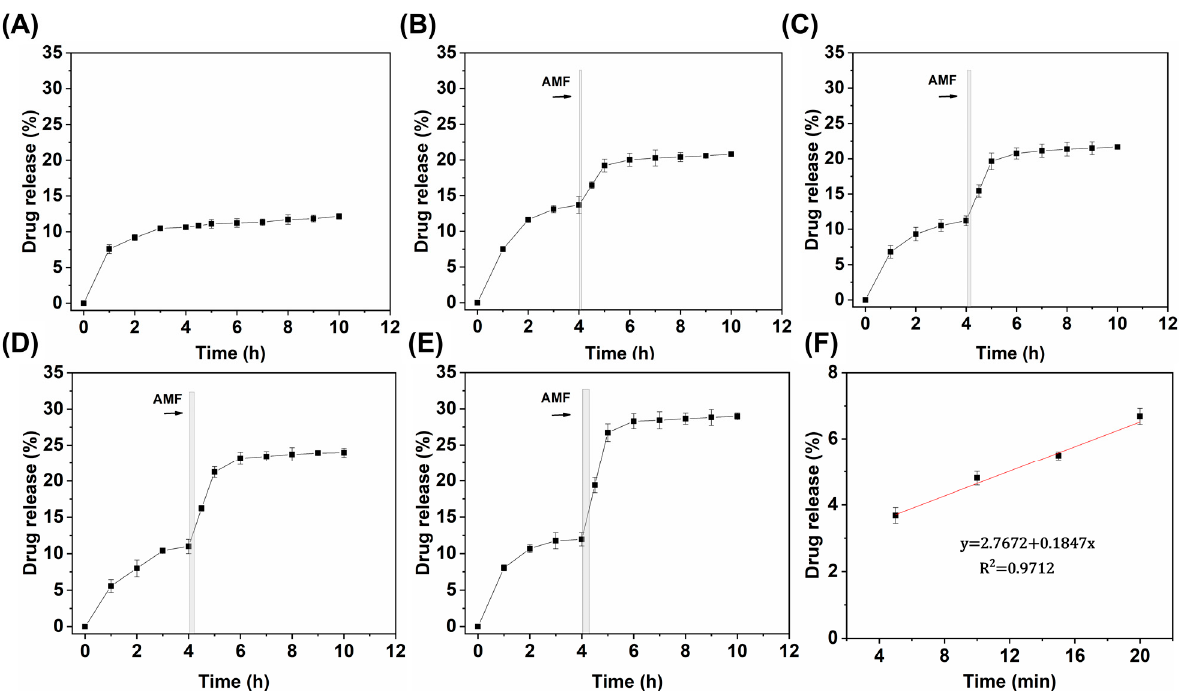
Figure 6. Magnet-controlled drug release plots of Fe 3 O 4 @CS-ACVA-TB nanoparticles: exposed to AMF for ( A ) 0 min, ( B ) 5 min, ( C ) 10 min, ( D ) 15 min and ( E ) 20 min. ( F ) The fitting curve of TB release content after different action times of AMF. (n = 3).